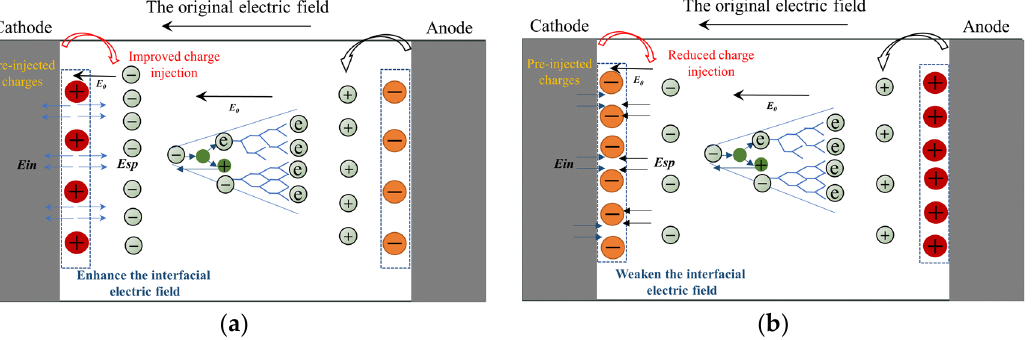
Figure 9. Schematic diagram of the effect of pre-applied space charge on breakdown strength. ( a ) heterocharges; ( b ) homocharges.